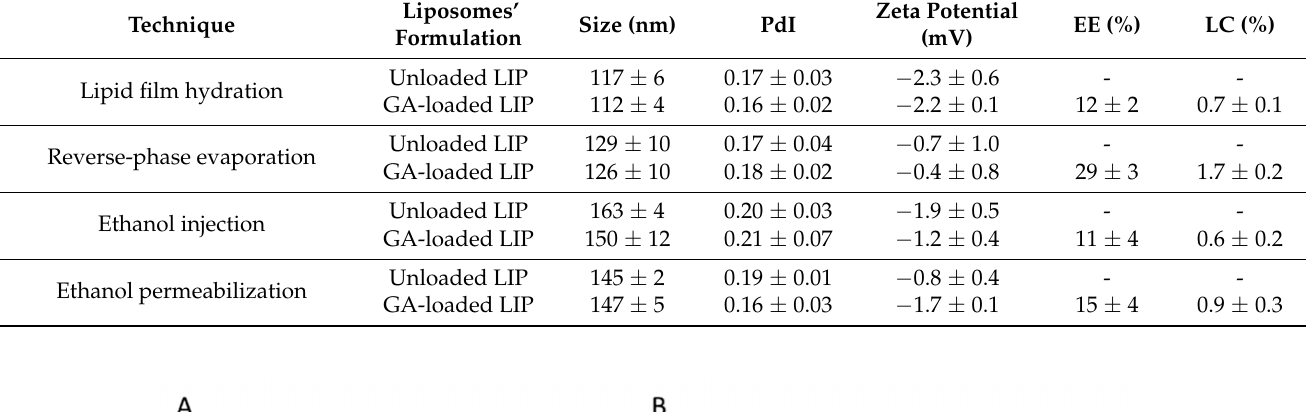
Table 1. Physicochemical properties of unloaded and GA-loaded liposomes, including hydrodynamic diameter, PdI, zeta potential, EE, and LC.